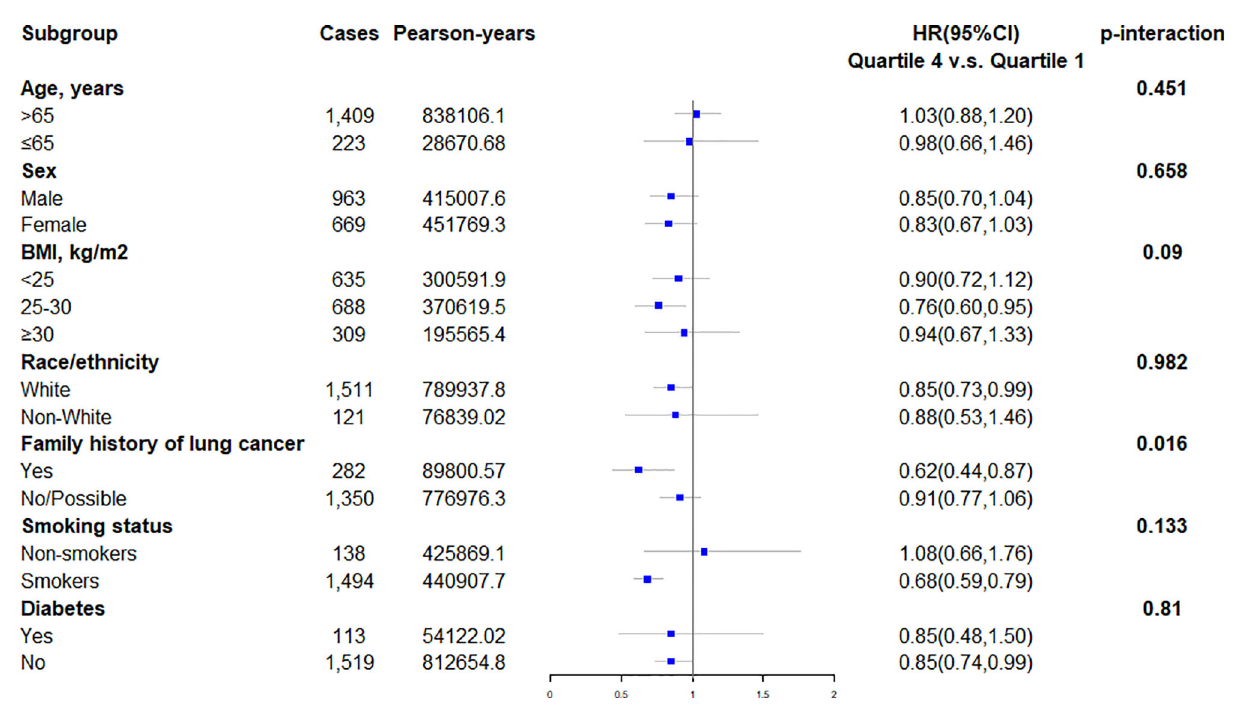
FIGURE 3 | Subgroup analyses evaluating the association between DRRD score and incidence of lung cancer modi fi ed by age (>65 vs. ≤ 65 years old), sex (male vs. female), BMI (>25 vs. 25-30 vs. ≥ 30 kg/m2), race/ethnicity (white vs. non-white), family history of lung cancer (yes vs. no/possible), smoking status (non-smokers vs. smokers), and history of diabetes (yes vs. no).